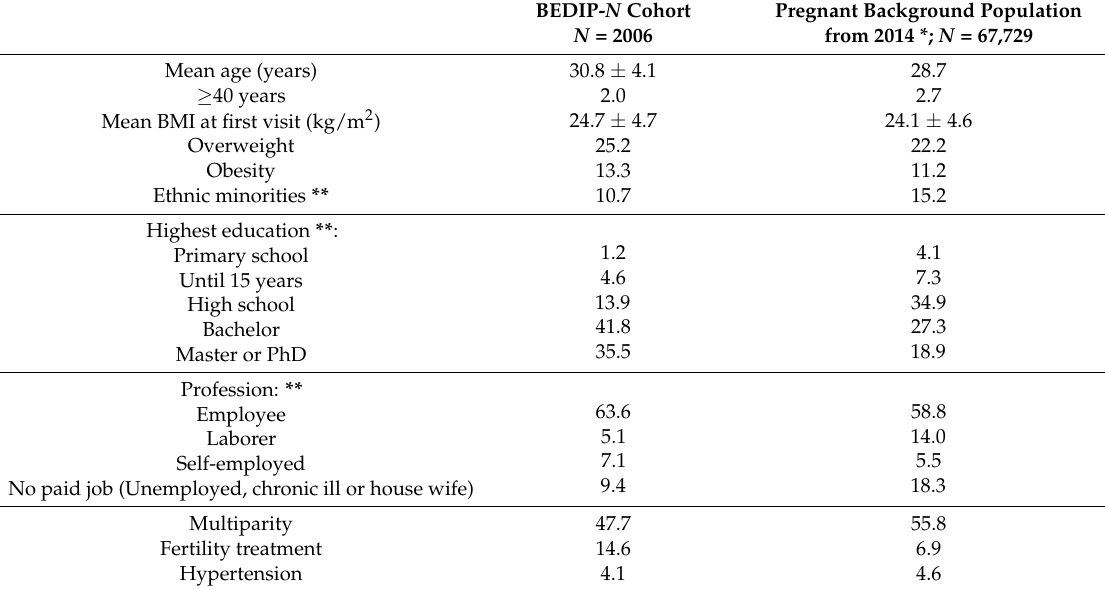
Table 2. Comparison of the baseline characteristics of the ‘Belgian Diabetes in Pregnancy’ study (BEDIP) cohort with the pregnant Flemish background